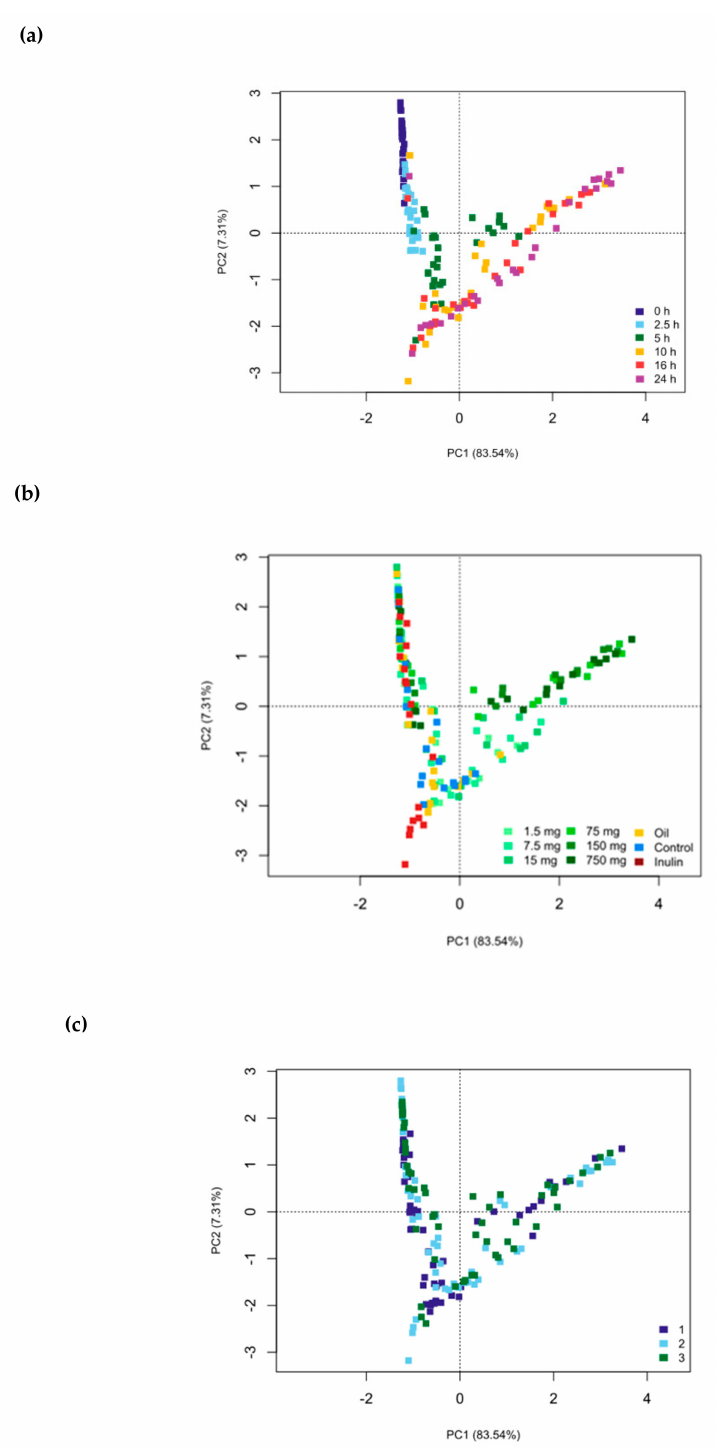
Figure 3. 16S rRNA gene sequencing data depicted as genus-level Euclidean principal coordinates analysis (PCoA) plots separated by time point ( a ) ( p < 0.001, R 2 = 43.4%), substrate ( b ) ( p < 0.001, R 2 = 28.5%) and fermentation replicates ( c ) ( p = 0.3248, R 2 = 1.4%). Significance ( p ≤ 0.05) was determined by the non-parametric Adonis statistical test (9999